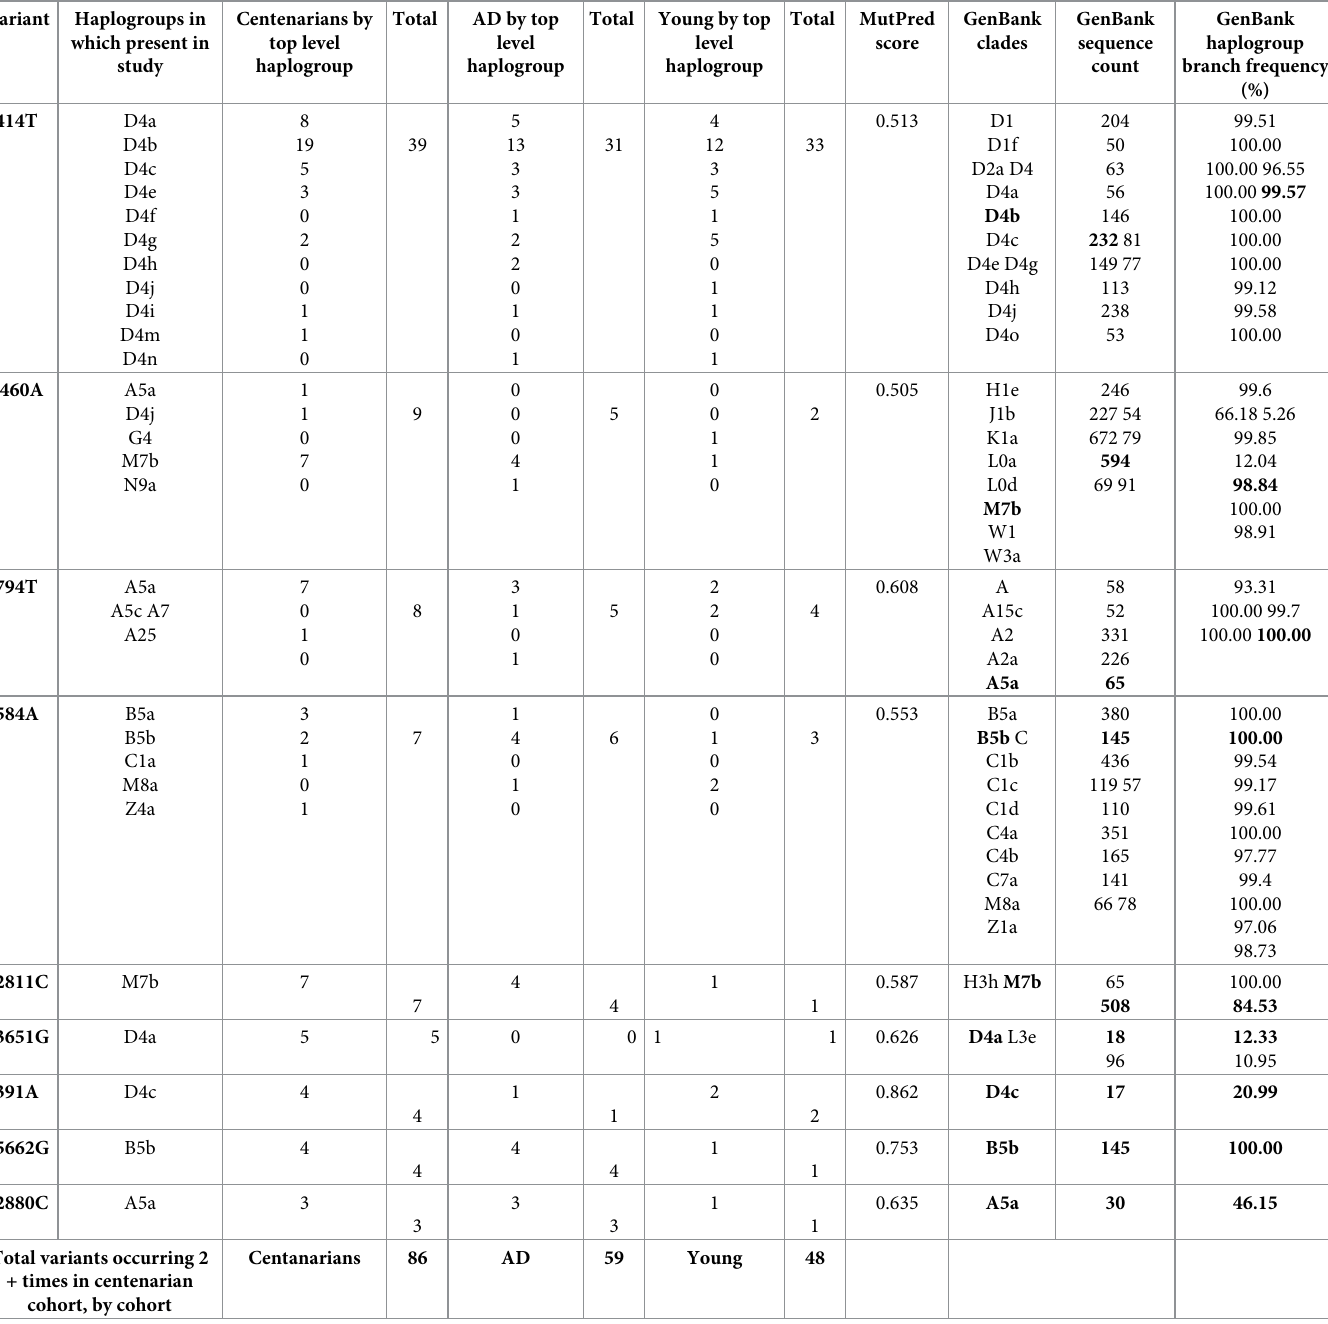
Table 2. Haplogroup context and common GenBank 2019 Haplogroup associations of variants scoring > 0.5 in MutPred found in the study population. Variant Haplogroups in which present